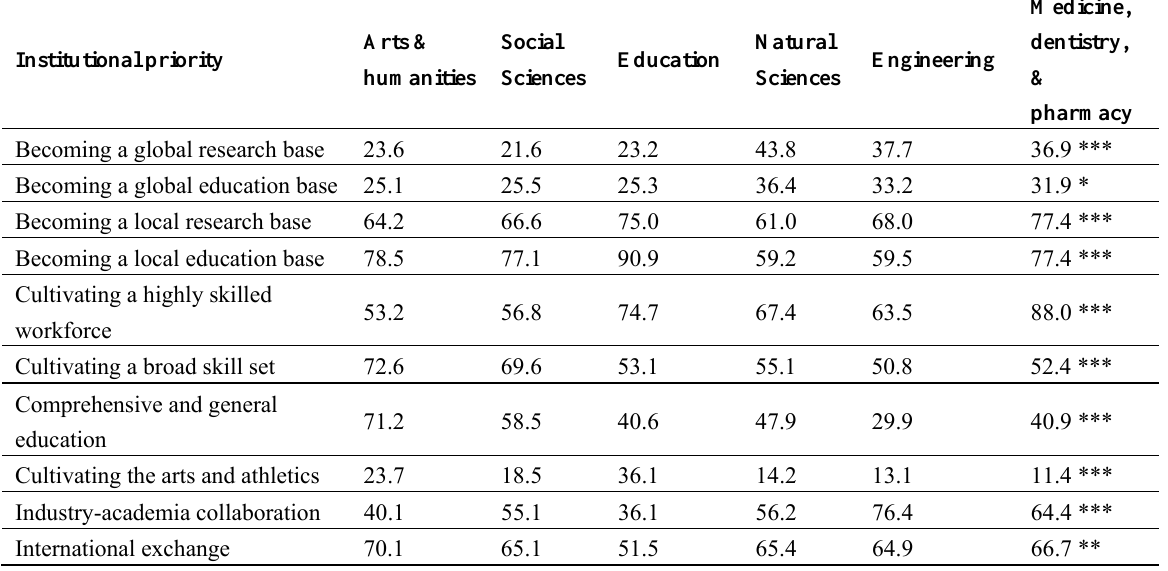
Table 4. Proportions of Japanese university executives acknowledging the listed academic priorities with positive perceptions, by academic discipline in